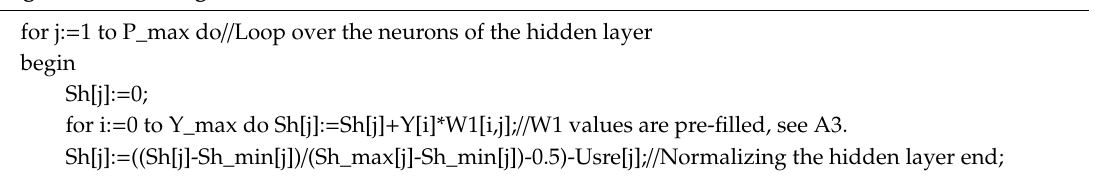
Algorithm A6.3. Algorithm 3.